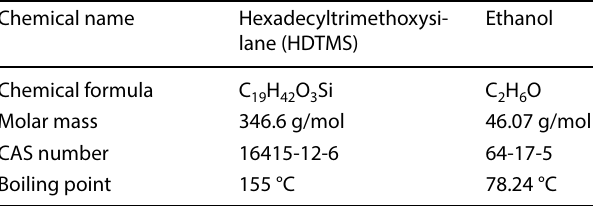
Table 1 Technical specification of different chemical